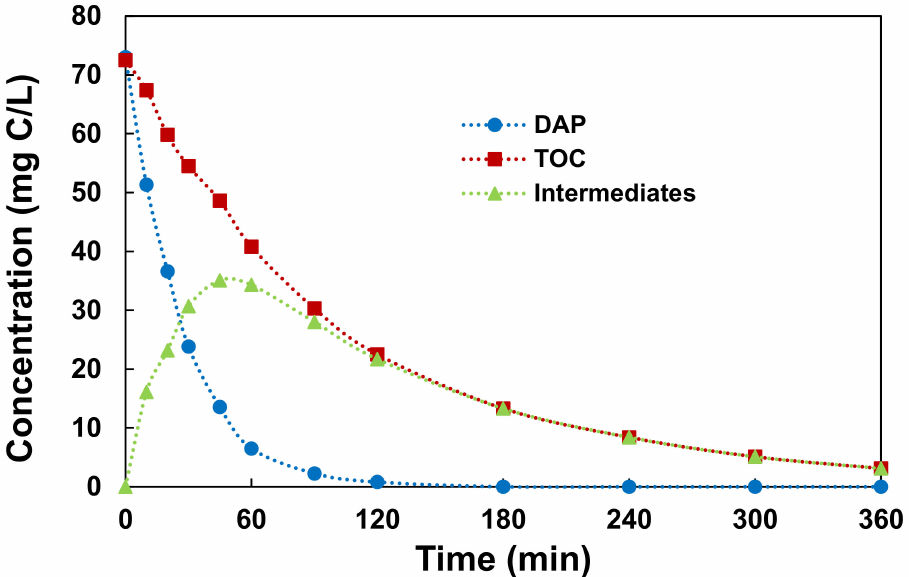
Figure 8. Changes in concentrations (mg C/L) of DAP, intermediates and TOC during Fenton oxidation of 100 mg/L DAP. Experimental conditions: [H 2 O 2 ] = 1000 mg/L; [Fe 2+ ] = 50 mg/L;